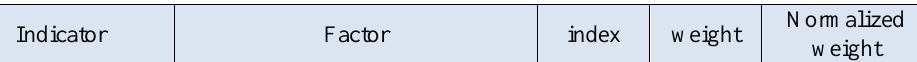
Table 10. ranking the most important